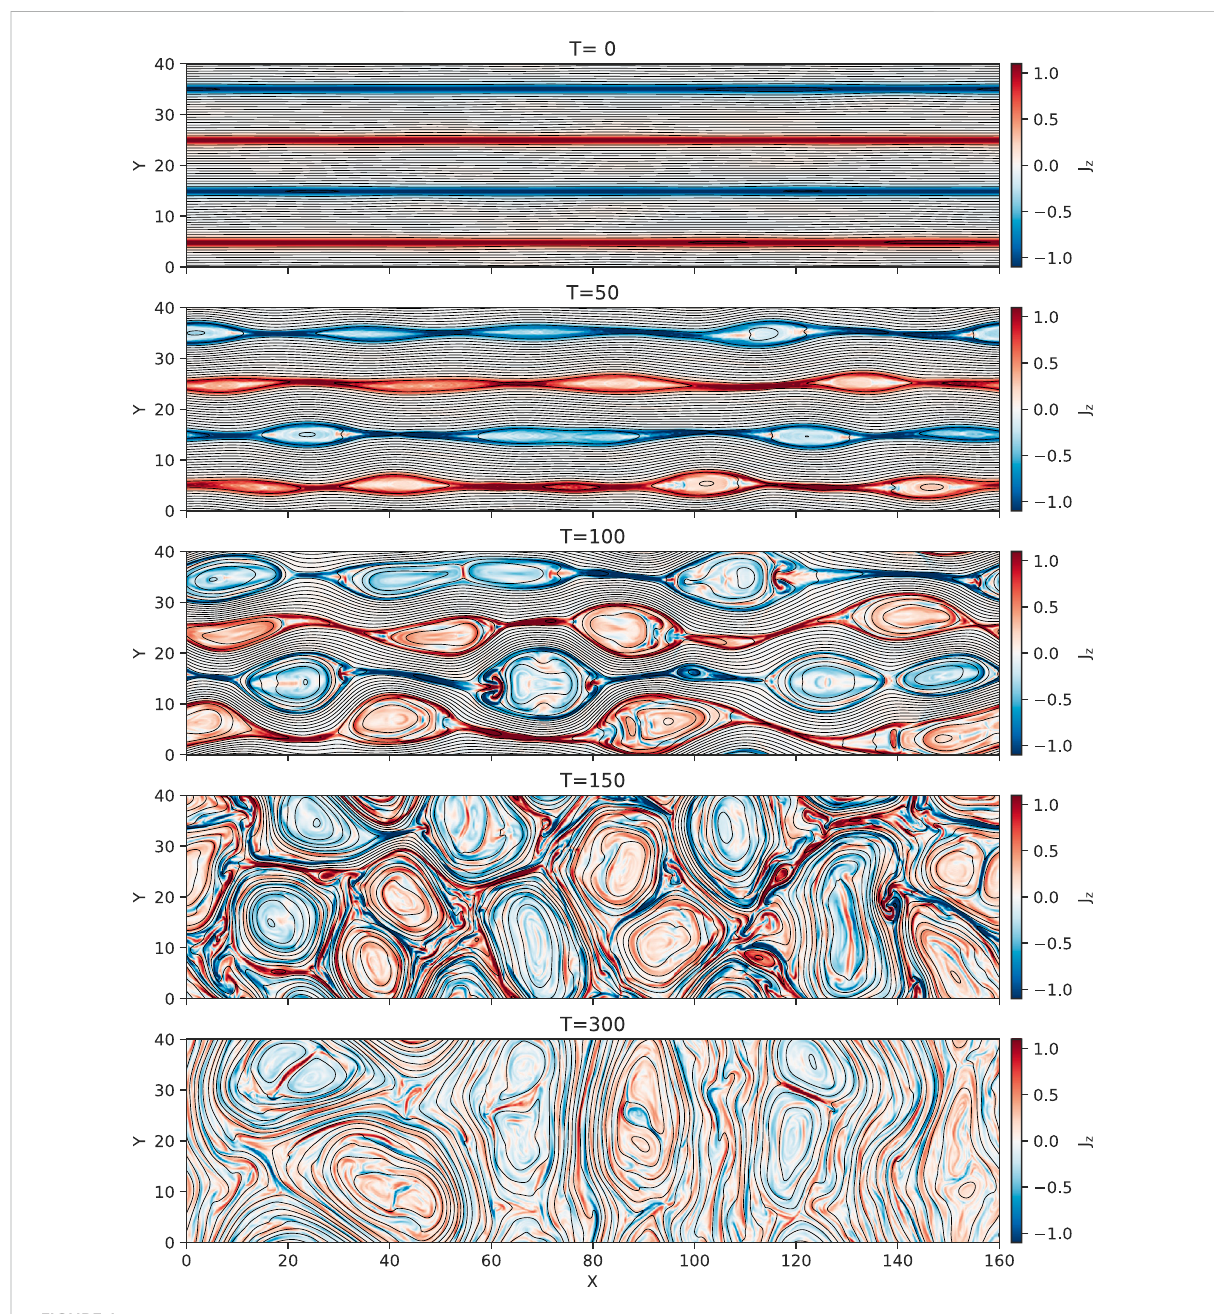
FIGURE 1 Snapshots of the current density J z in the 2D case at different times, t = 0, 50, 100, 150, 300 from top to bottom. Black lines represent the magnetic fi eld lines (contour lines for the vector potential A z